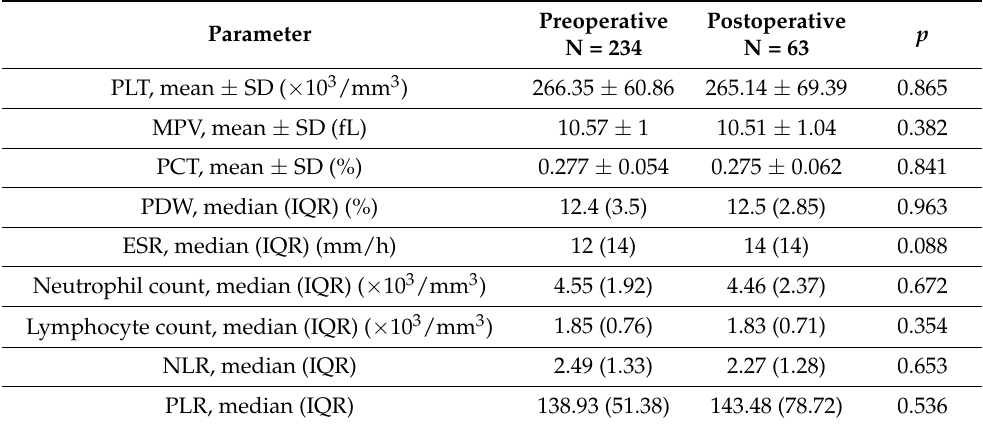
Table 7. Univariate comparative analysis of pre- and postoperative levels of inflammatory markers and platelet indices in PTC